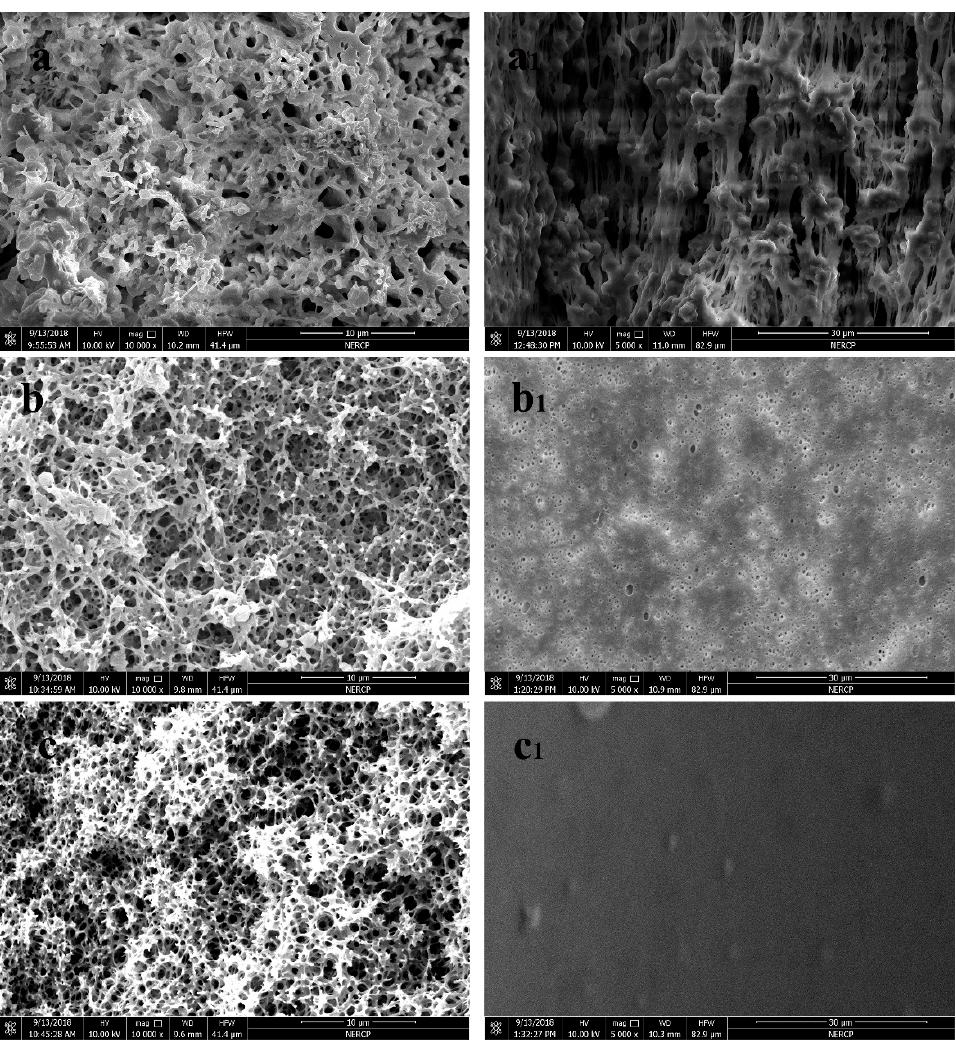
Figure 1. Cross-section and internal surface morphology of three hollow fiber virgin membranes; ( a ) is PVDF membrane; ( b ) is PP membrane; ( c ) is PSF membrane; ( a ), ( b ) and ( c ) are the morphology of cross-section; ( a 1 ), ( b 1 ) and ( c 1 ) are the morphology of internal surface.